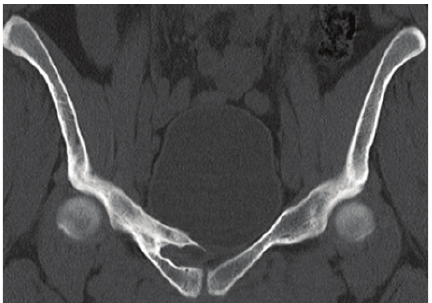
Figure 3: CT coronal slice of the pelvis demonstrating a malunited right superior pubic fracture with a bony spur projecting through the bladder wall.